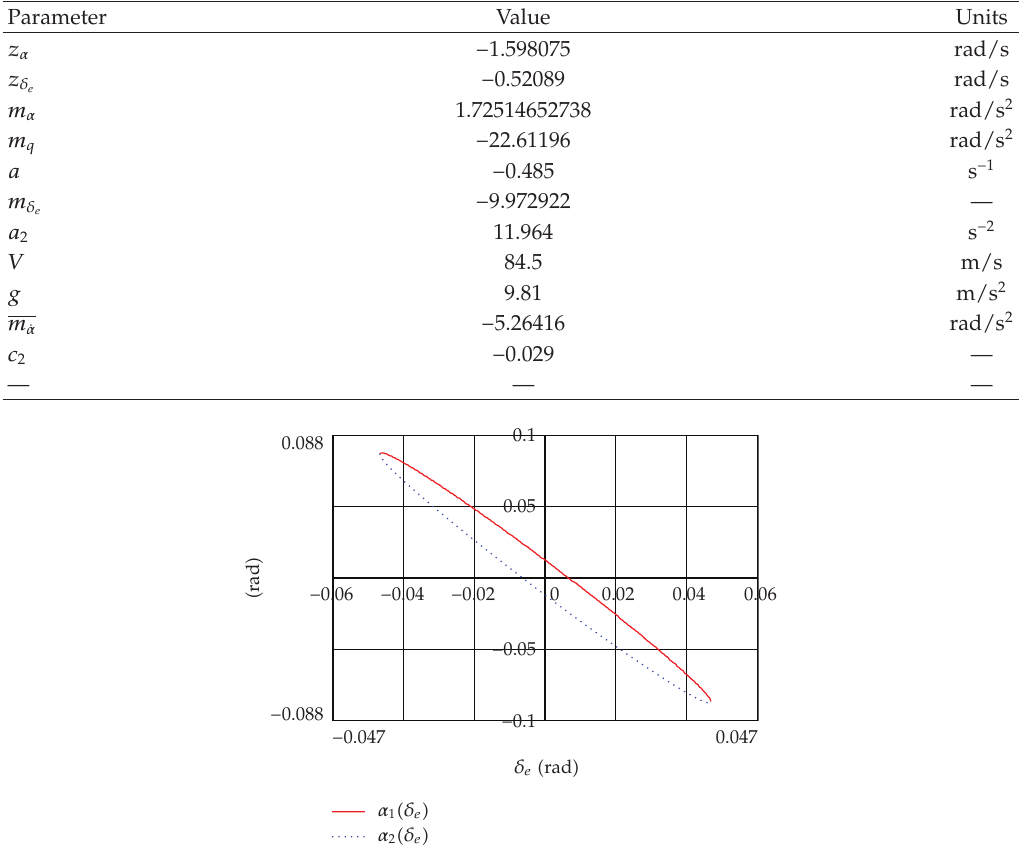
Figure 1: The α 1 (cid:3) δ e (cid:4) and α 2 (cid:3) δ e (cid:4) coordinates of the equilibriums on the manifold M V .